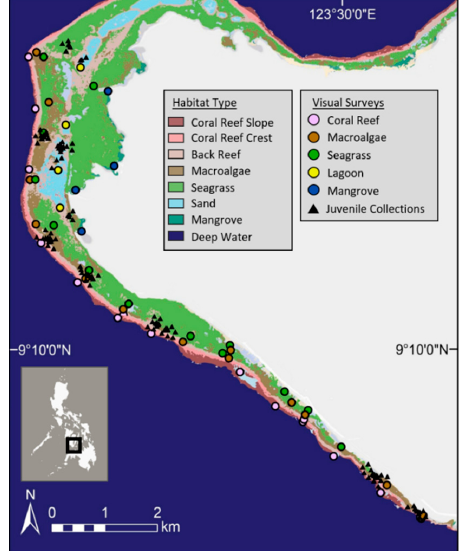
Figure 1. Map of the western section of Siquijor Island in the Philippines: coloured circles mark the centroid of the sites surveyed within each habitat. Black triangles mark the collection locations for juvenile parrotfishes.